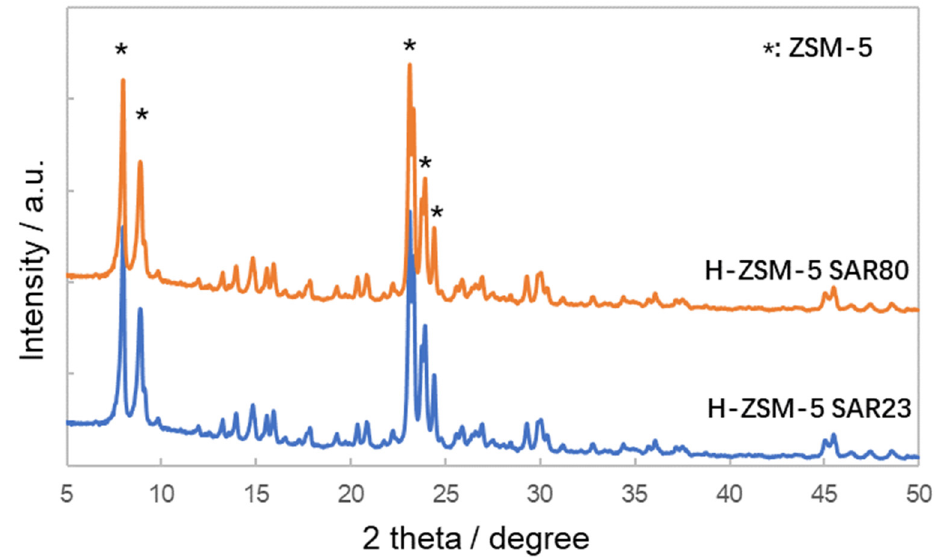
Figure 1. XRD patterns of H-ZSM-5 SAR23 and H-ZSM-5 SAR80.